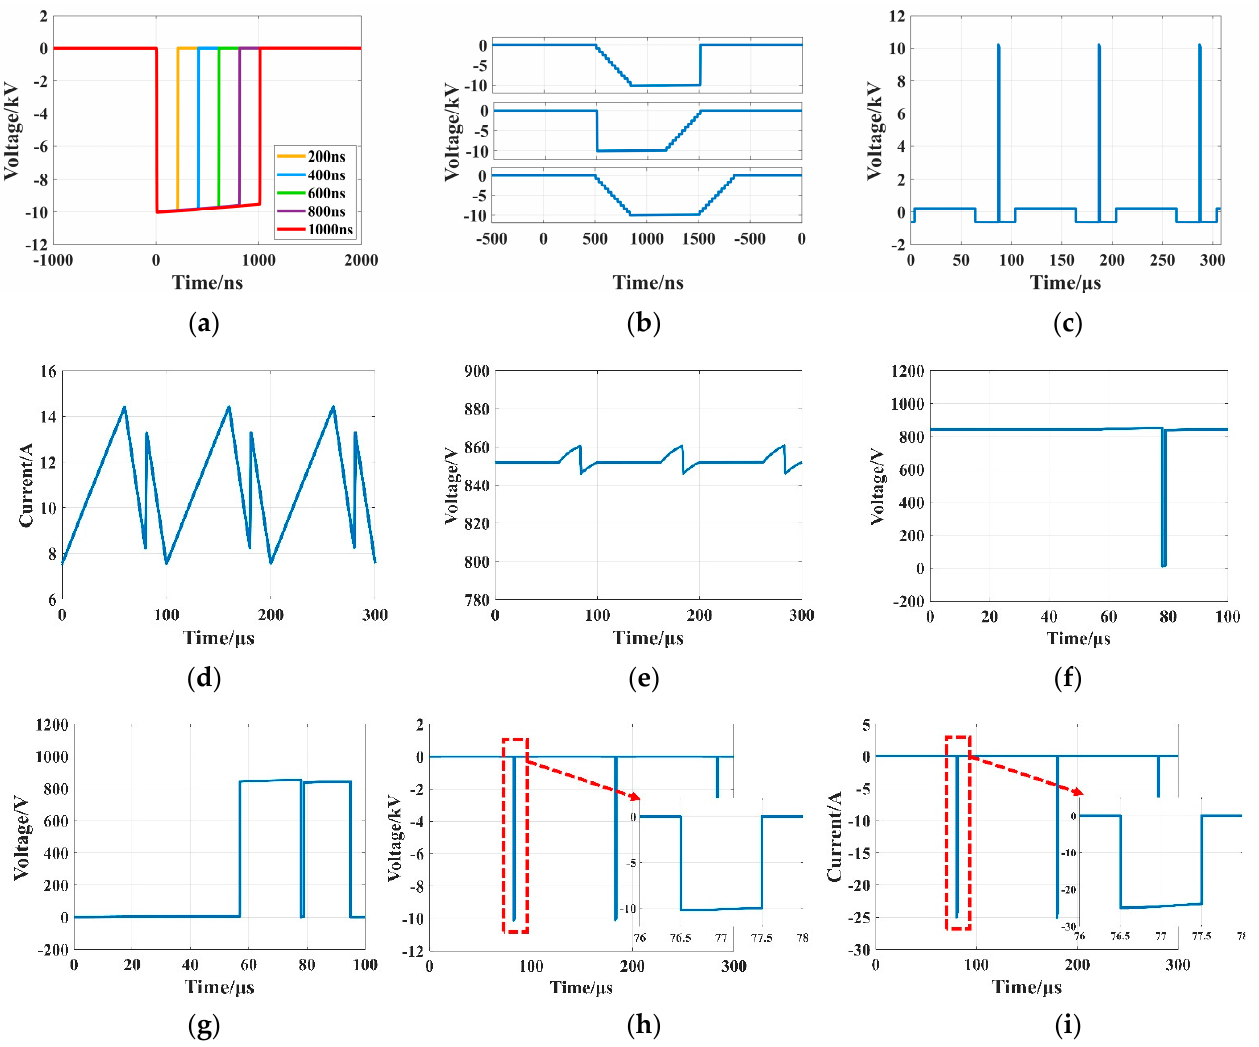
Figure 8. Simulation results of BMPG circuit (pulse frequency 10 kHz, amplitude 10 kV) ( a ) Pulse waveforms with different pulse widths ( b ) Pulse waveforms with different rising and falling time ( c ) Inductor voltage waveform ( d ) Inductor current waveform ( e ) Capacitance Voltage waveform ( f ) Switch M 1 ~ M 12 drain-source voltage ( g ) Switch M 0 drain-source voltage ( h ) Output pulse voltage waveform ( i ) Output pulse current pulse.